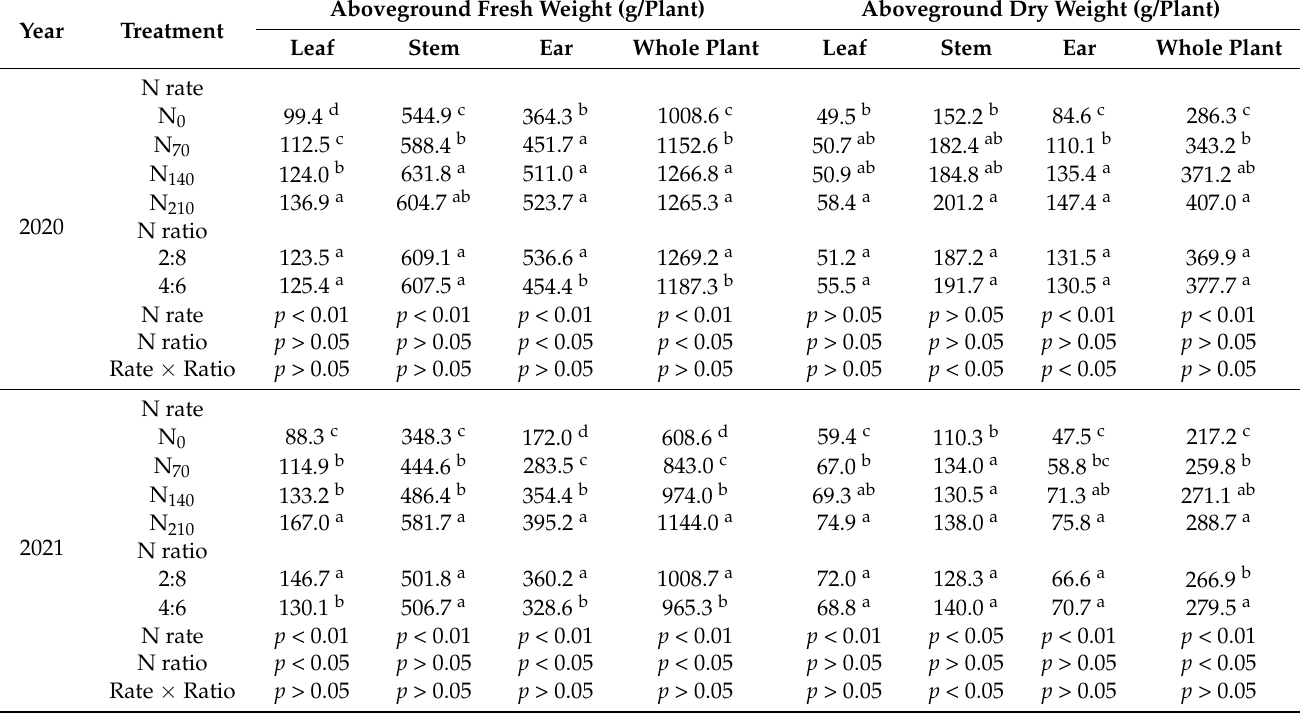
Table 3. Effects of different fertilization rates and basal topdressing ratios on fresh and dry weights in 2020 and